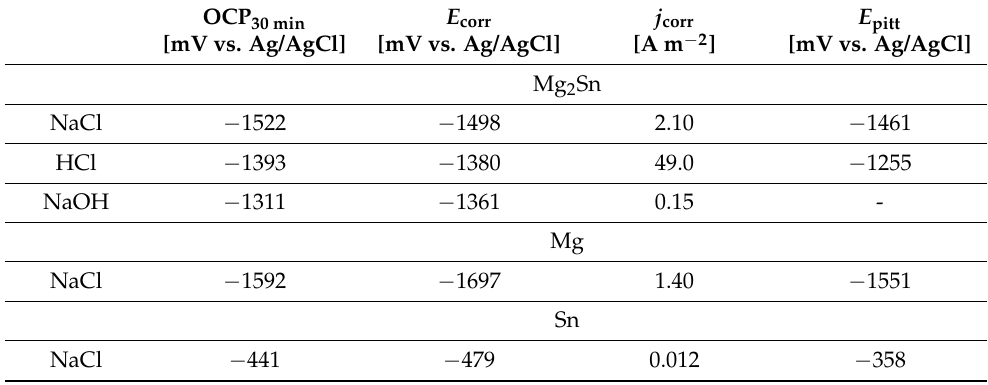
Table 4. Electrochemical parameters of the as-cast Mg 2 Sn alloy in 3.5 wt.% NaCl, 0.1 wt.% HCl and 0.1 wt.% NaOH aqueous solutions at room temperature. Results for Mg and Sn measured in 3.5 wt.% NaCl are also included.